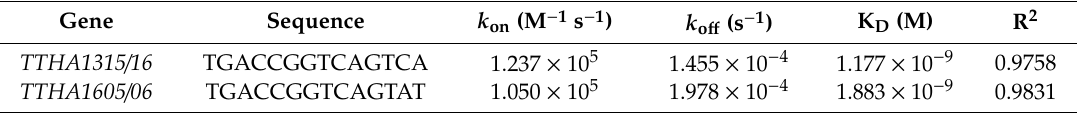
Table 6. TTHA0167-promoter binding